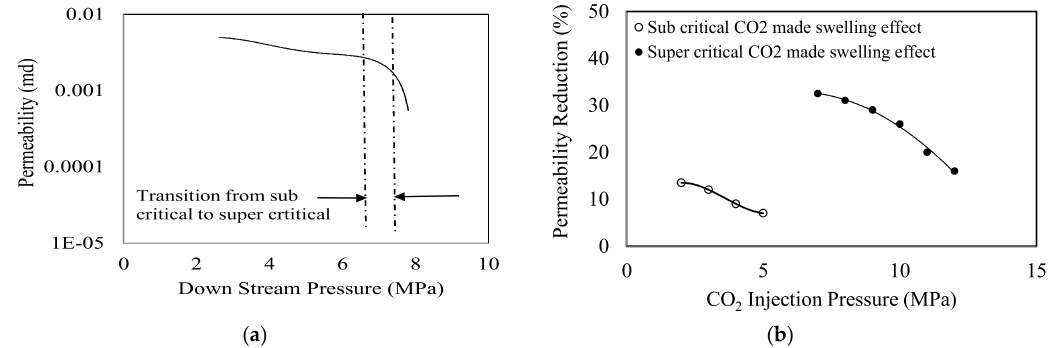
Figure 10. Variation of coal permeability with pore pressure for both sub-critical and super- critical CO 2. ( a ) Down Stream Pressure [3]; ( b ) CO 2 Injection Pressure